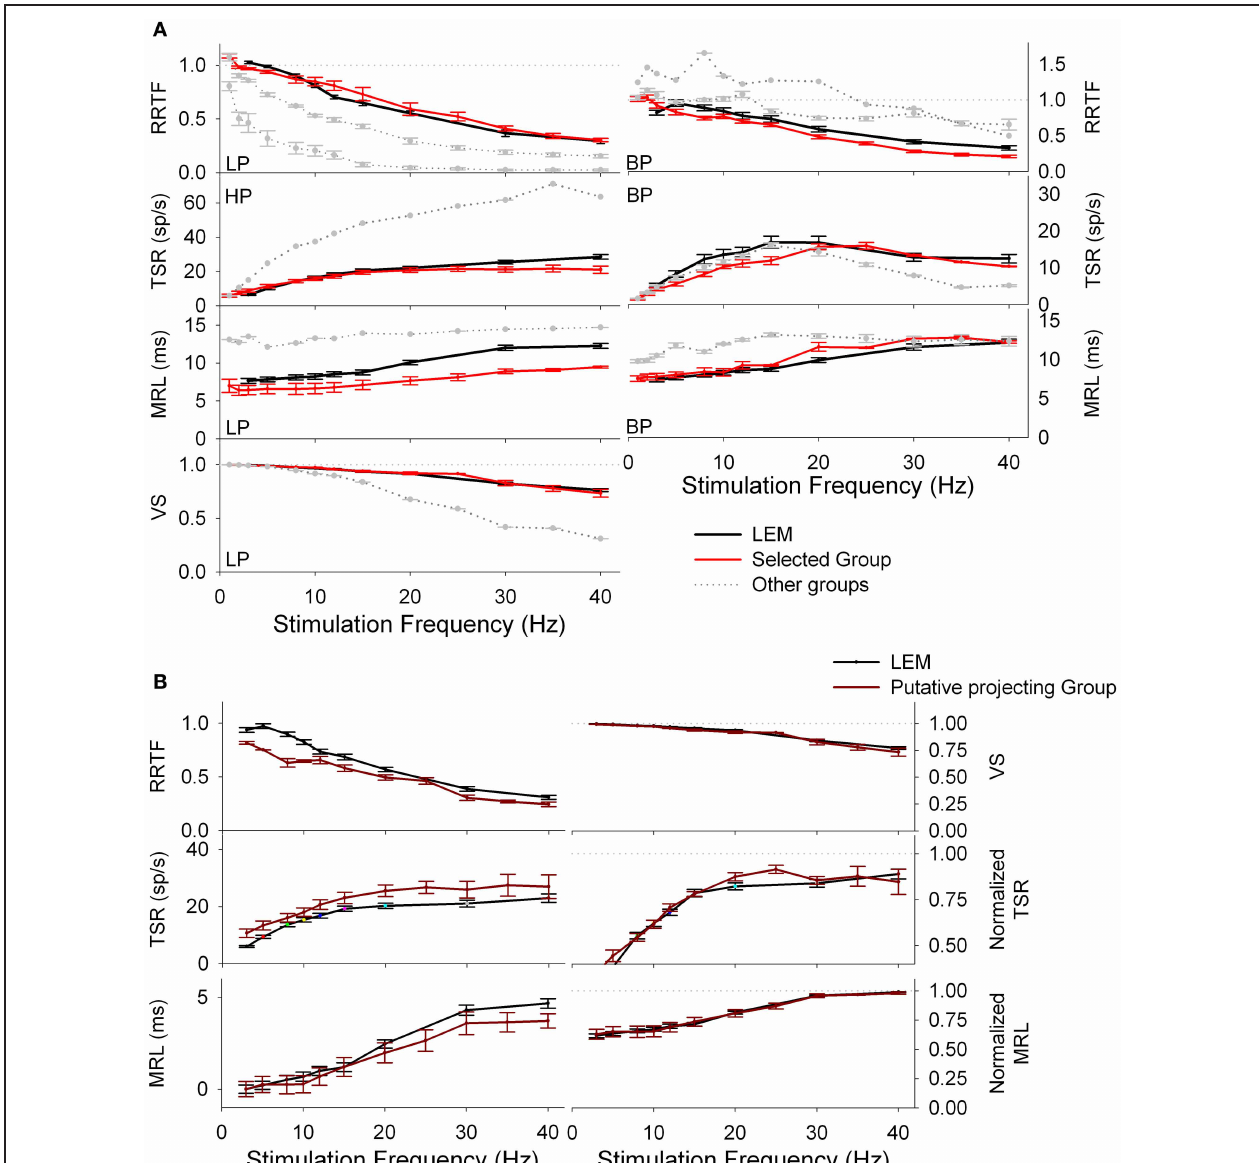
FIGURE 5 | GroupseparationoftonicPrVrecordingsaccordingtothetype of the response (LP/HP or BP). (A) RRTF, TSR, MRL, and VSvalues of tonic PrV responses are clustered; for each stimulation frequency mean values are calculated and plotted (in gray-black) together with the mean values of the lemniscal recordings (in red). PrV clusters closest to the lemniscal ones (in black) areexpected tocontain the thalamicprojecting neurons. However,not all